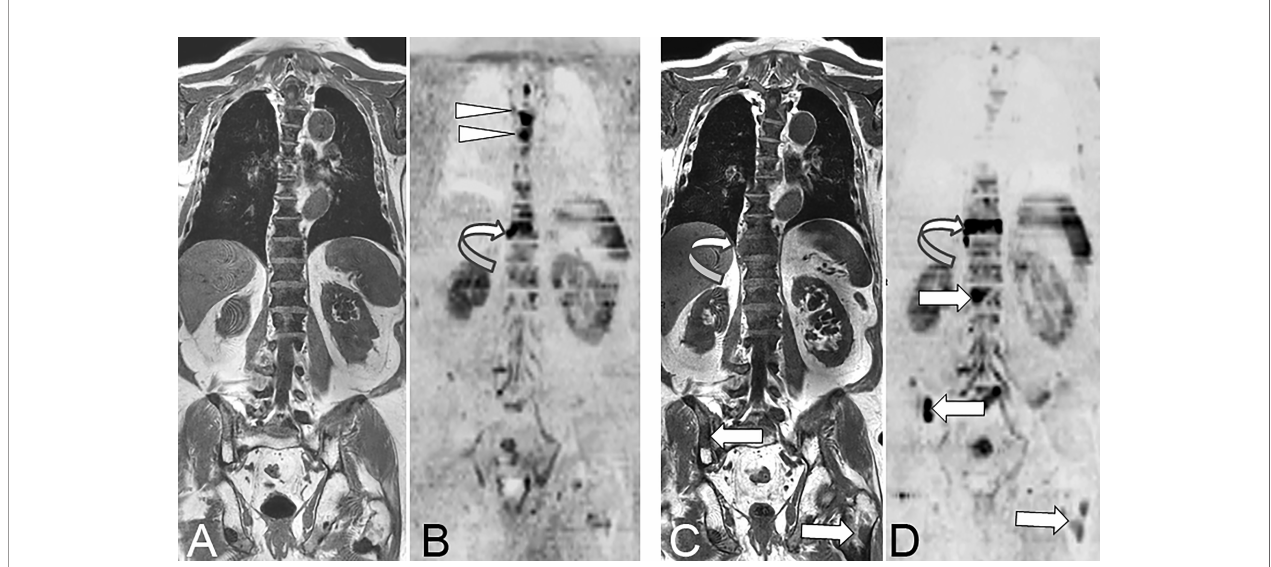
FIGURE 2 | 73 year-old man with advanced prostate cancer. Comparison of pre- and post-treatment (enzalutamide) WB-MRI/DWI. Baseline coronal T1-weighted MR image (A) shows diffuse bone marrow in fi ltration within the spine, responsible for diffuse low signal intensity of the bone marrow, and related to advanced metastatic disease after several lines of treatment. The pelvic bones show higher signal of the bone marrow indicating a fatty content due to previous irradiation. Several focal lesions of low signal intensity are visible within the pelvis and left proximal femur. Baseline DWI MR image ( B ; B = 1000 s/mm 2 , inverted grey scale) shows high signal intensity foci typical for active bone metastases within the T4, T5 (arrowheads) and T10 (curved arrow) vertebrae. Follow-up T1-weighted MR image (C) shows no evident change of the spinal bone marrow, but increase in the right paraspinal extension of the T10 metastasis (curved arrow), and a new lesion within the right posterior iliac crest (arrow). Follow-up DWI MR image (D) shows disappearance of the midthoracic vertebral lesions, but increase in size and right paraspinal extension of the T10 vertebral lesion (curved arrow), and appearance of new lesions within the L1 vertebral body, the right iliac crest and left proximal femur (arrows). The observation of concurrent signs of disease response and progression is frequent, especially in advanced stages of metastatic